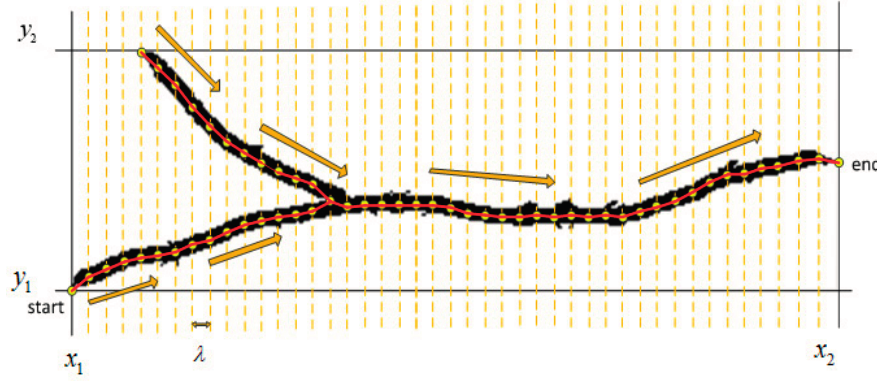
Figure 9. Computation process of crack skeleton